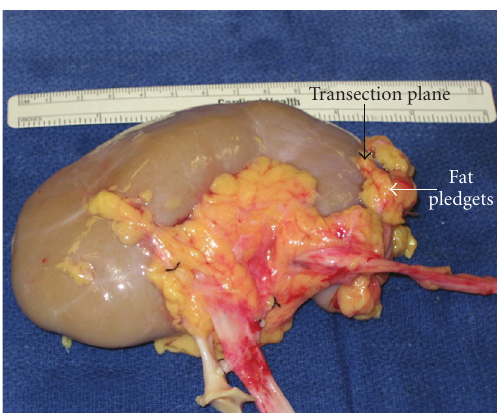
Figure 2: This intraoperative picture shows the renal mass on the back table, prior to transection.